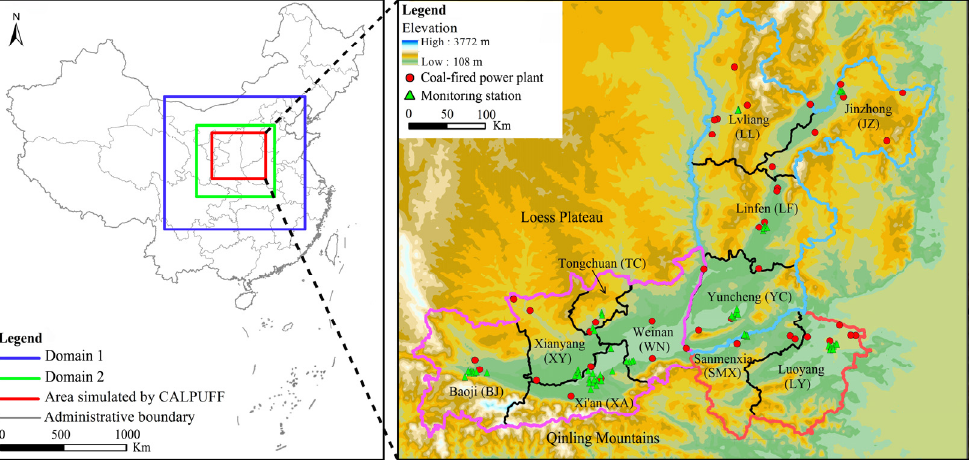
Figure 1. The location and topography of the Fenwei Plain (FWP) and the simulated domains.